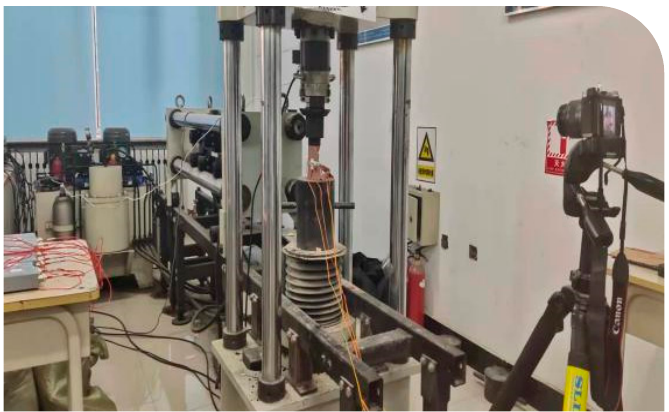
Figure 3. Rock triaxial test system.